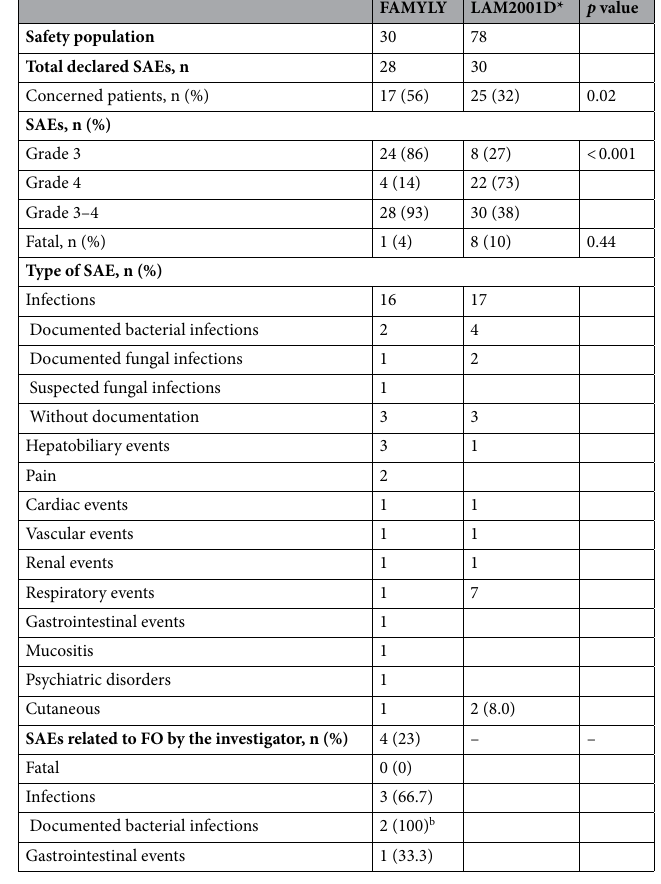
Table 2. Serious adverse events (SAEs) in patients treated in the FAMYLY study compared to the daunorubicin arm of the LAM2001 study in patients with adverse cytogenetics. SAE severe adverse events. candidiasis. c E. Coli bacteriemia and Clostridium difficile colitis in the same patient.